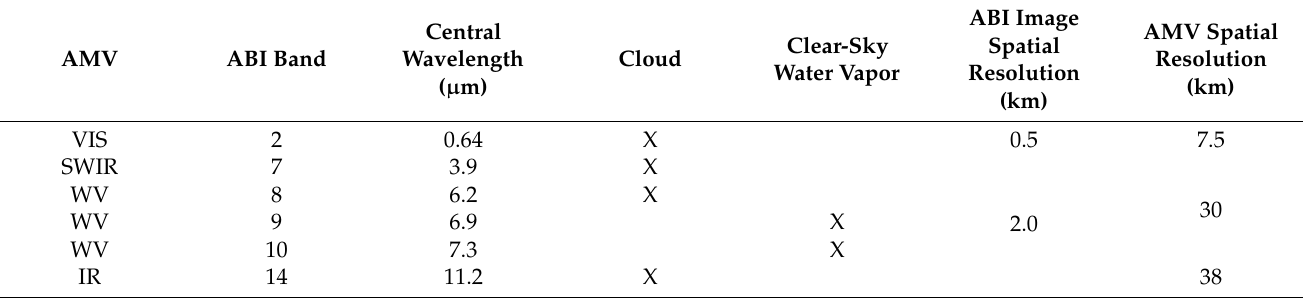
Table 1. GOES-16 and 17 imager spectral channels used to derive the different AMV